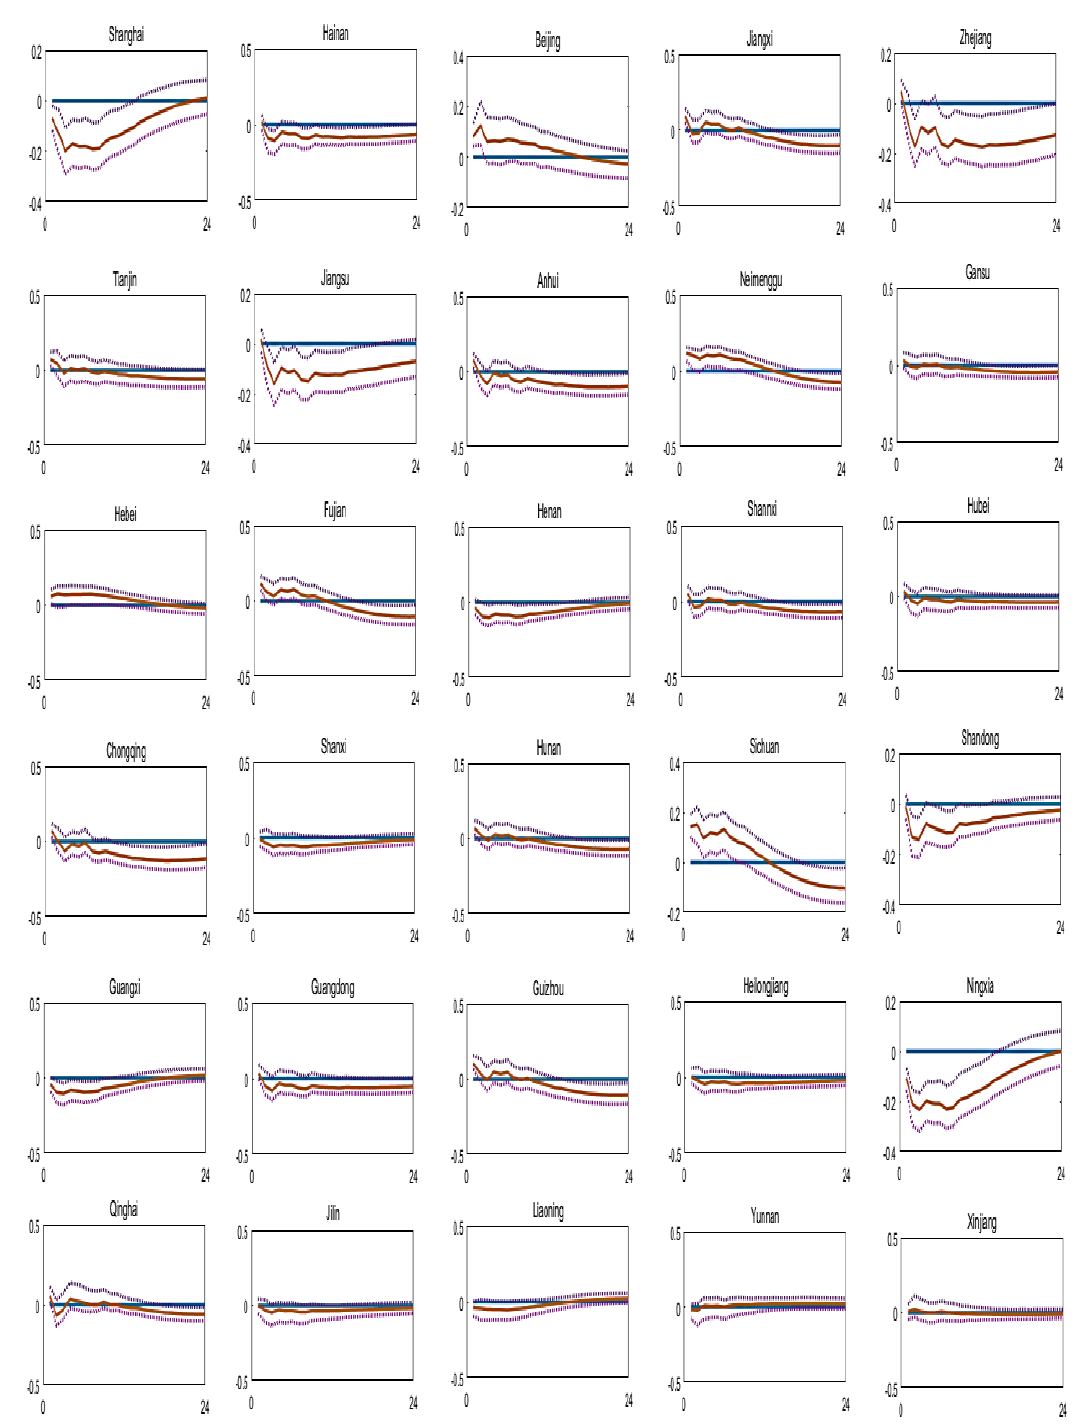
Figure 5. Impulse responses of regional house prices to one standard error shock to inflation rate: FAVAR system with one factor.